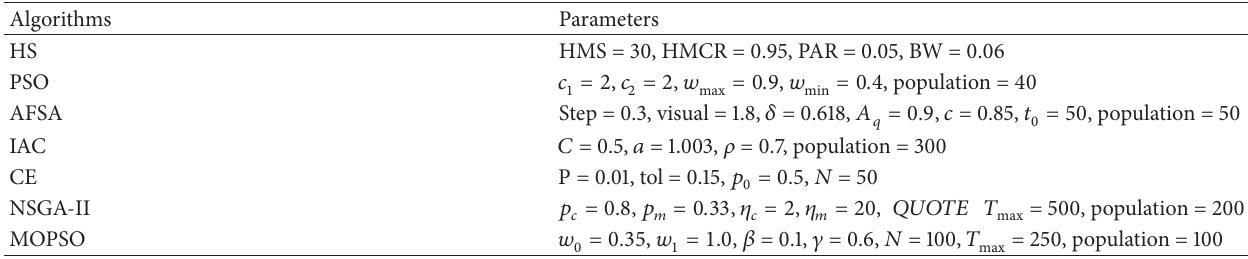
Table 2: The parameters of each optimization method.